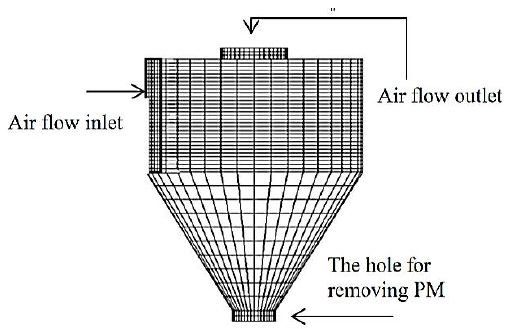
Figure 2. Drafted mesh of the calculation grid for the multi-channel cylindrical cyclone